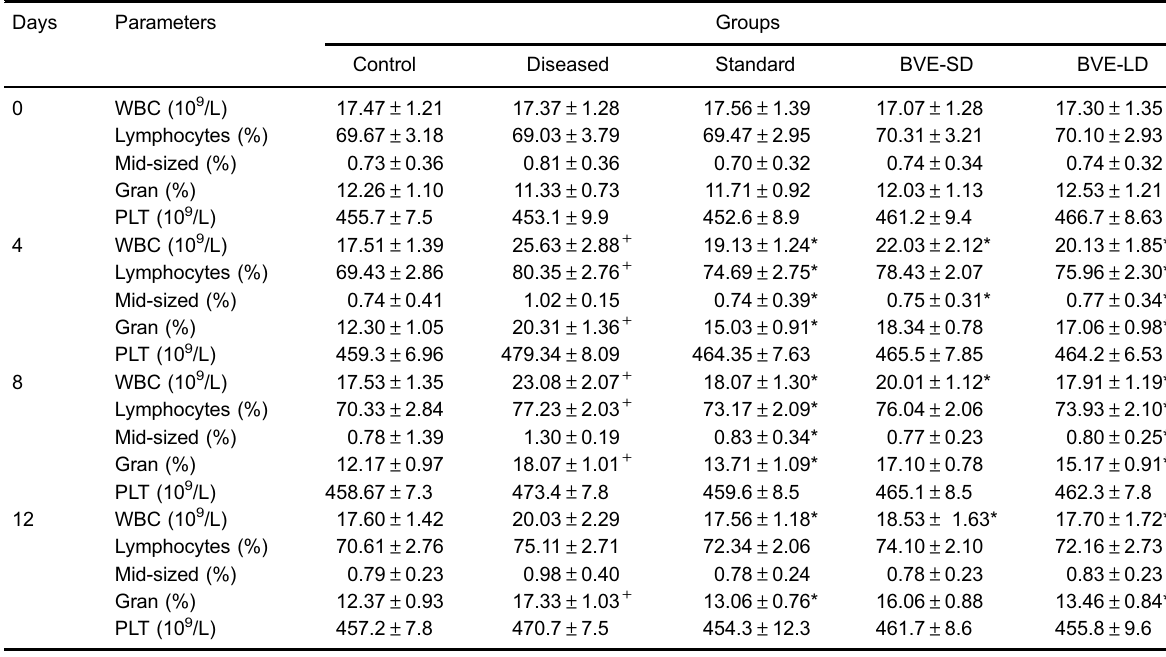
Table 2. Leukogram and platelet count after intraperitoneal injections of phenylhydrazine (20 mg/kg bw, for two consecutive days) and oral administration of Beta vulgaris leaf and stalk extract (BVE-LD, BVE-SD, 100 and 200 mg/kg b wt., for 12 consecutive days), compared to those after the standard ferrous ascorbate + folate (13.5 + 0.135 mg/kg bw, for 12 consecutive days) and normal control